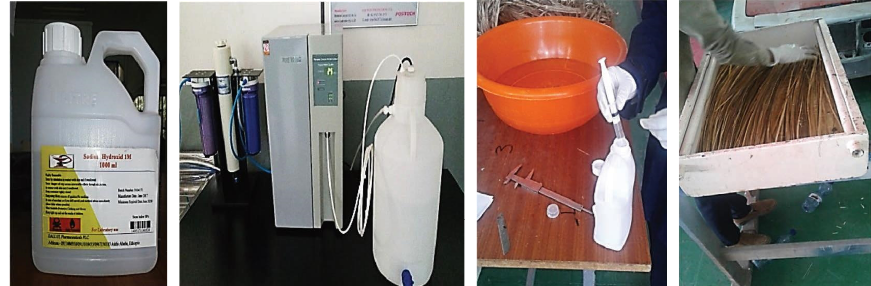
Figure 2: Chemical treatment of bamboo strips.